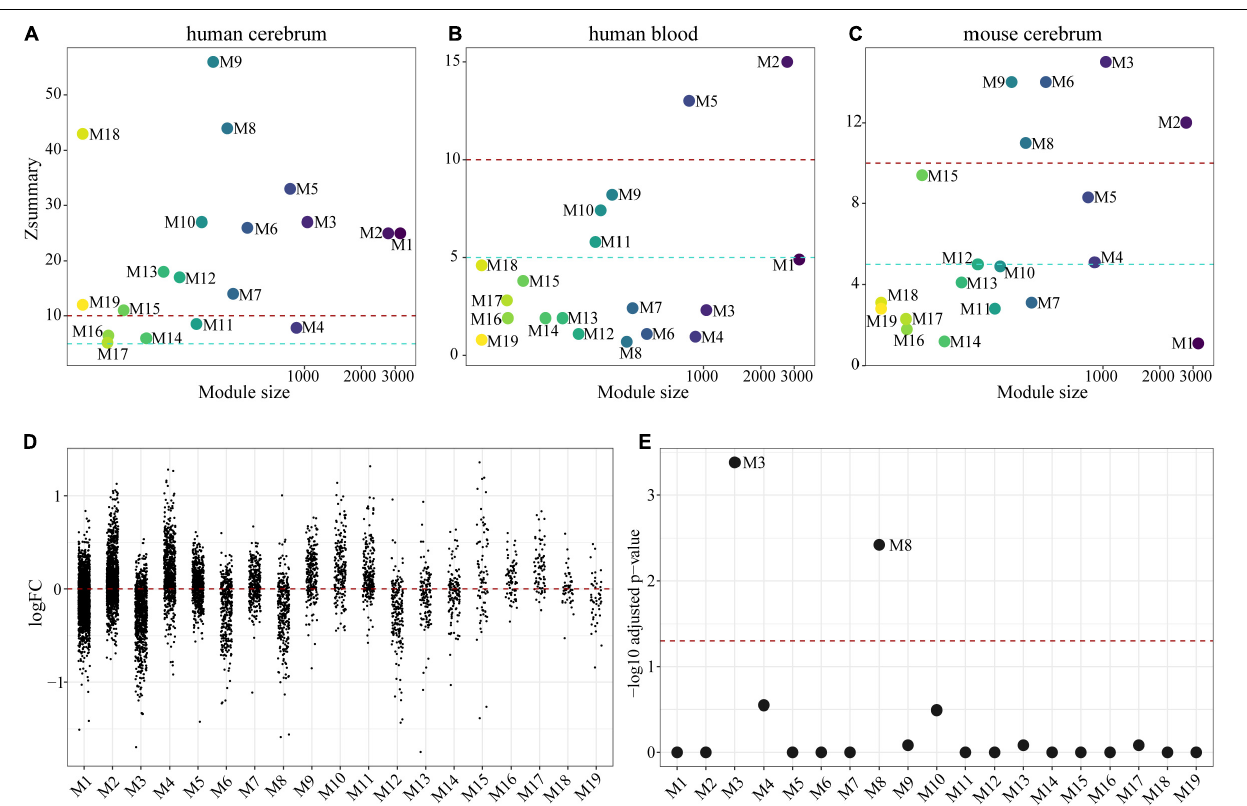
FIGURE 2 | Preservation of co-expressed modules and identification of AD-related modules. (A–C) Preservation scores for 19 co-expressed modules in other expression datasets: (A) across multiple cerebral regions of aging human brains, (B) of human blood tissue, (C) across aging mouse cortex and hippocampus. Each dot represents a weighted gene co-expression network analysis (WGCNA) module. Dashed red and blue lines represent Zsummary = 10 and Zsummary = 5, respectively. (D) LogFC values of genes in each module between AD patients and controls. (E) Statistical significance of each module enriched with AD-correlated genes. Q -values were determined by FET p -values corrected with the Benjamini-Hocheberg method. Each dot represents a module and a dashed line means FET q =